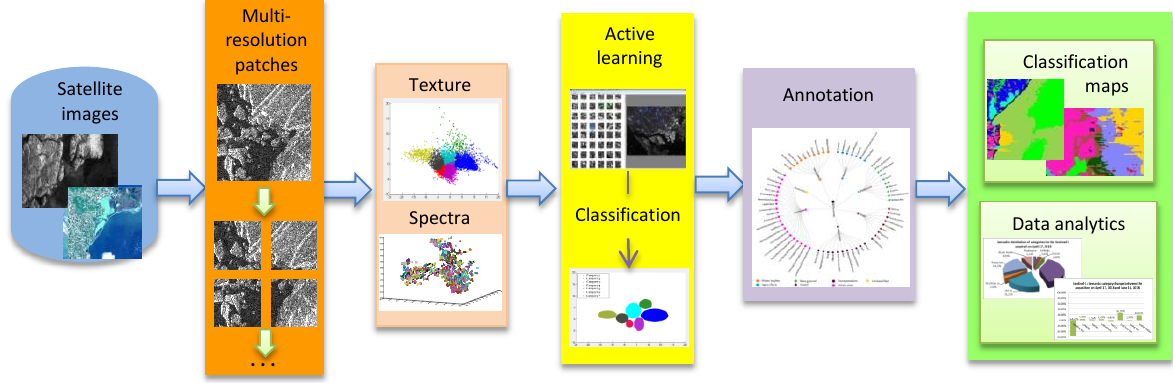
Figure 2. Processing flow used to generate semantically annotated data, classification maps, and analytics.